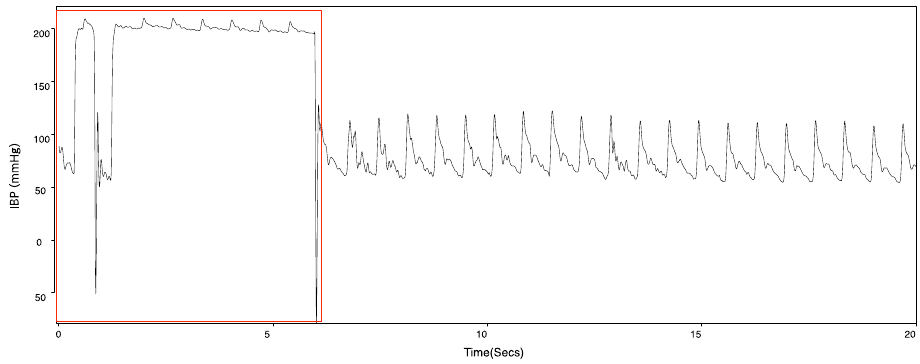
Figure 2. Artifacts marked in red on the time series of IBP.